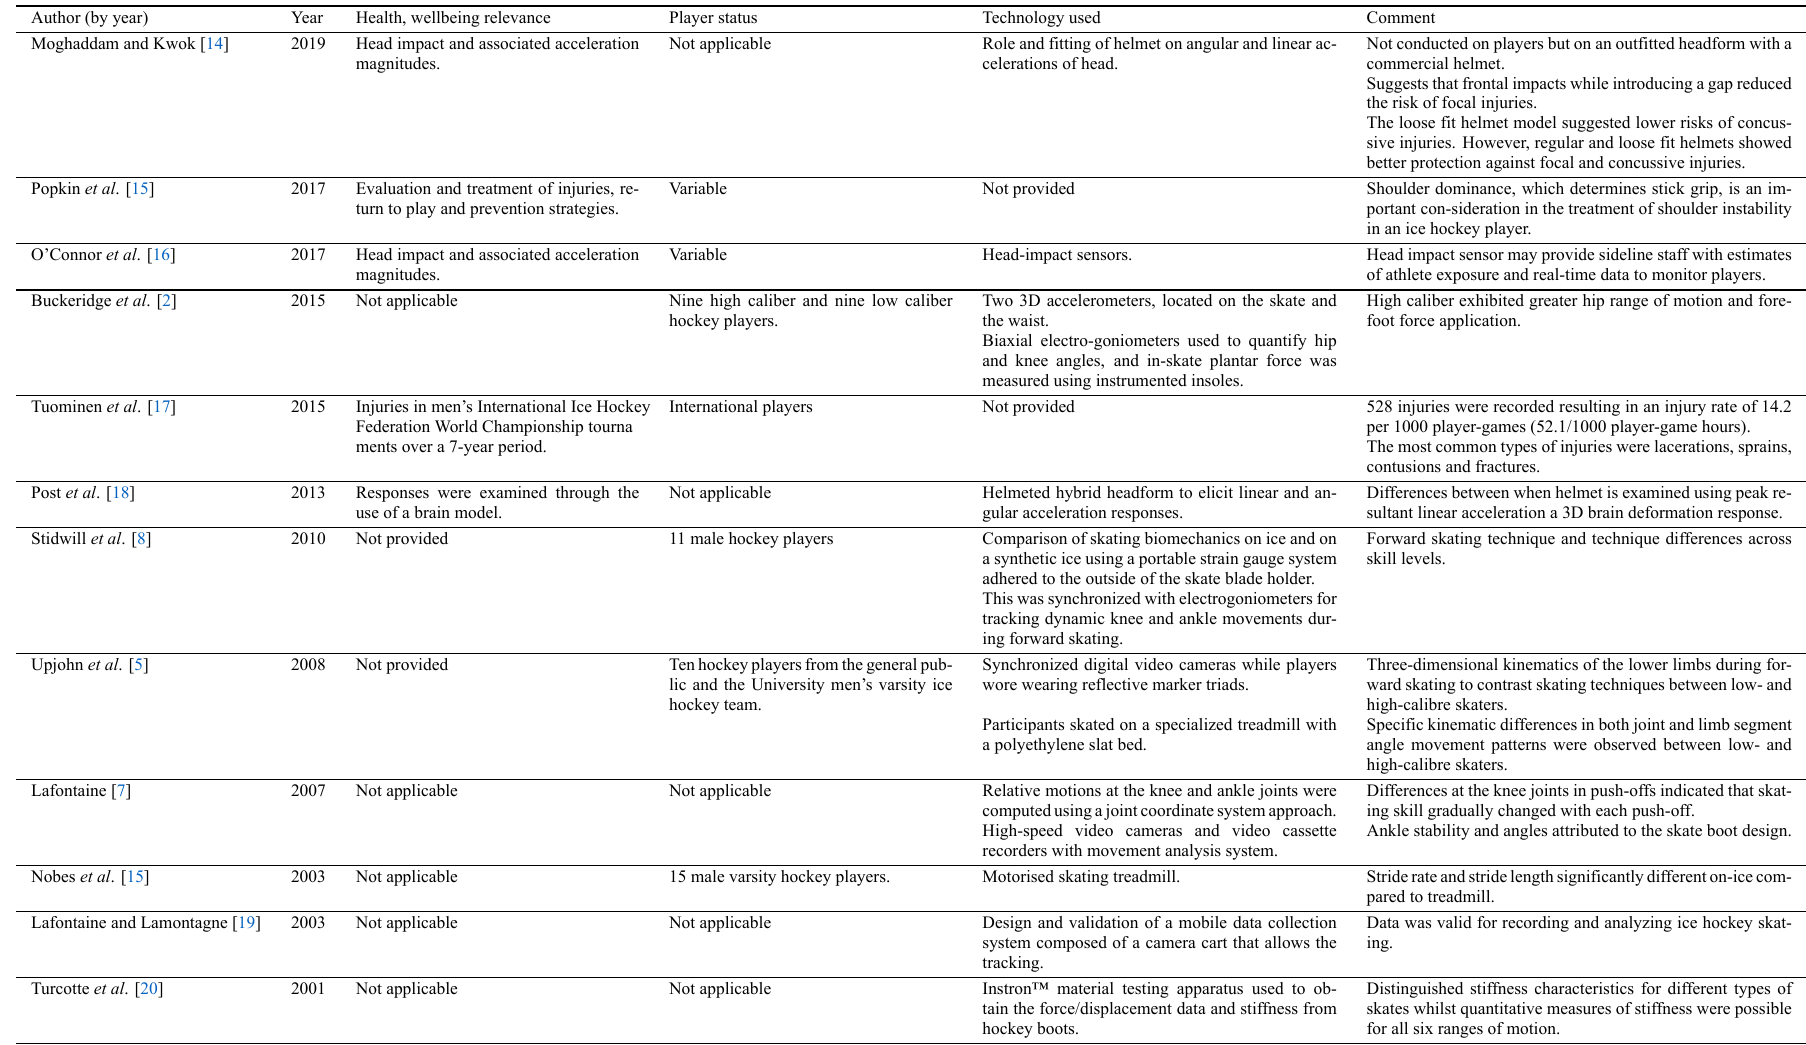
Table 2. Summary of studies investigating ice hockey biomechanics, technology and